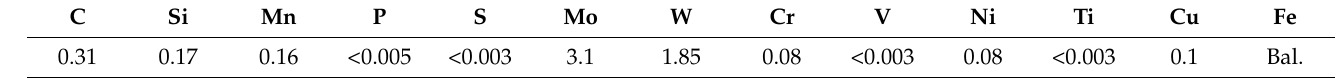
Table 1. Chemical composition of Rovalma HTCS 150 (mass%).